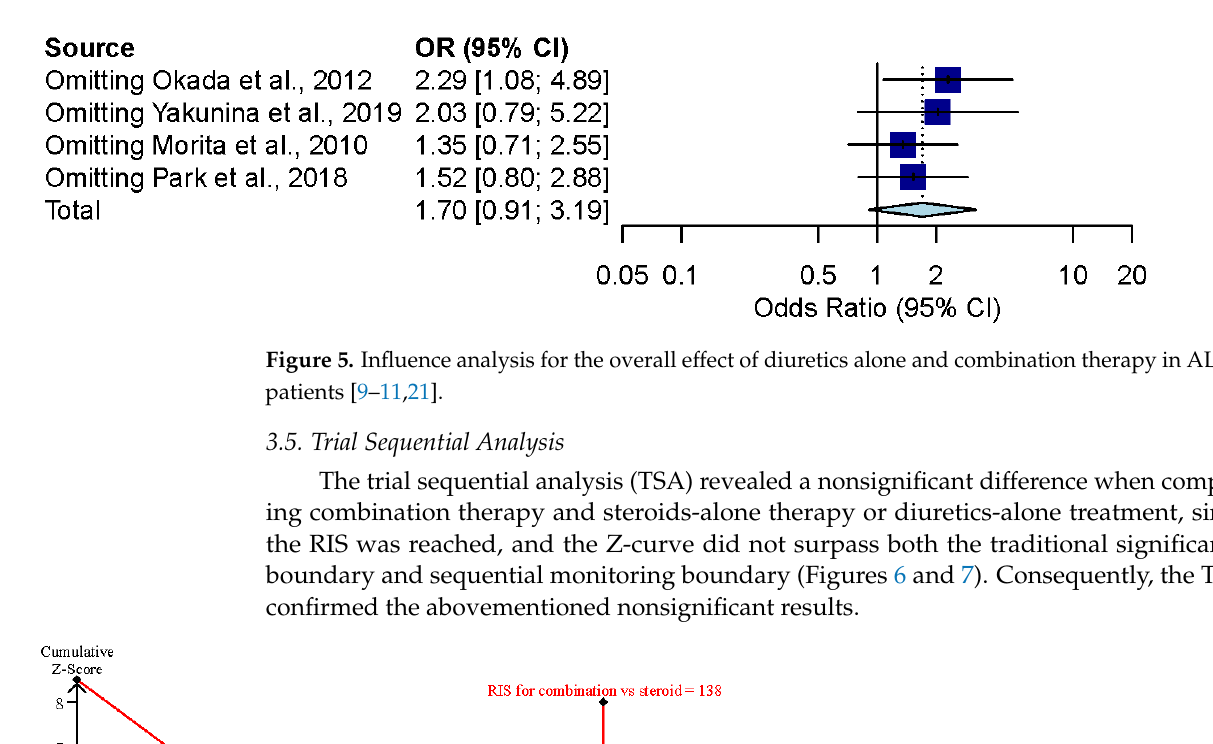
Figure 6. TSA comparing steroids alone and combination therapy.